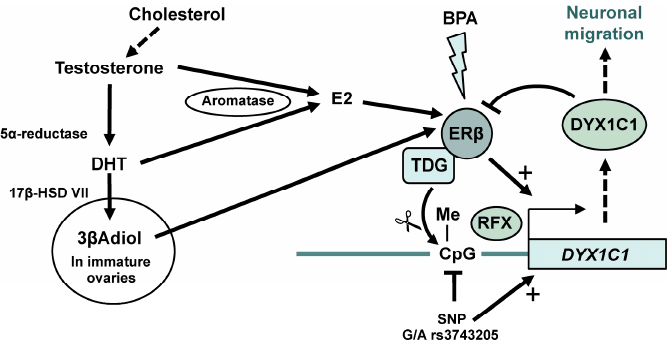
Figure 1. A model of how 17 β -estradiol (E2) and 3 β Adiol production may affect ER β regulation of dyslexia susceptibility 1 candidate gene 1 ( DYX1C1 ) gene expression during neuronal development.